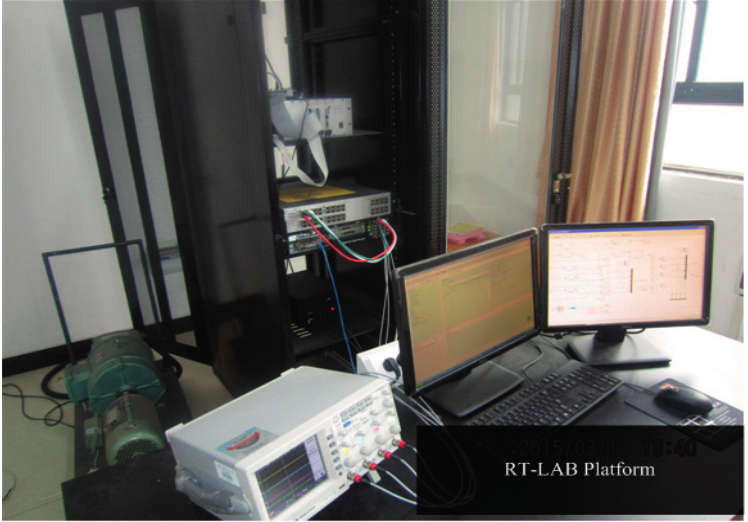
Figure 24. The RT-LAB